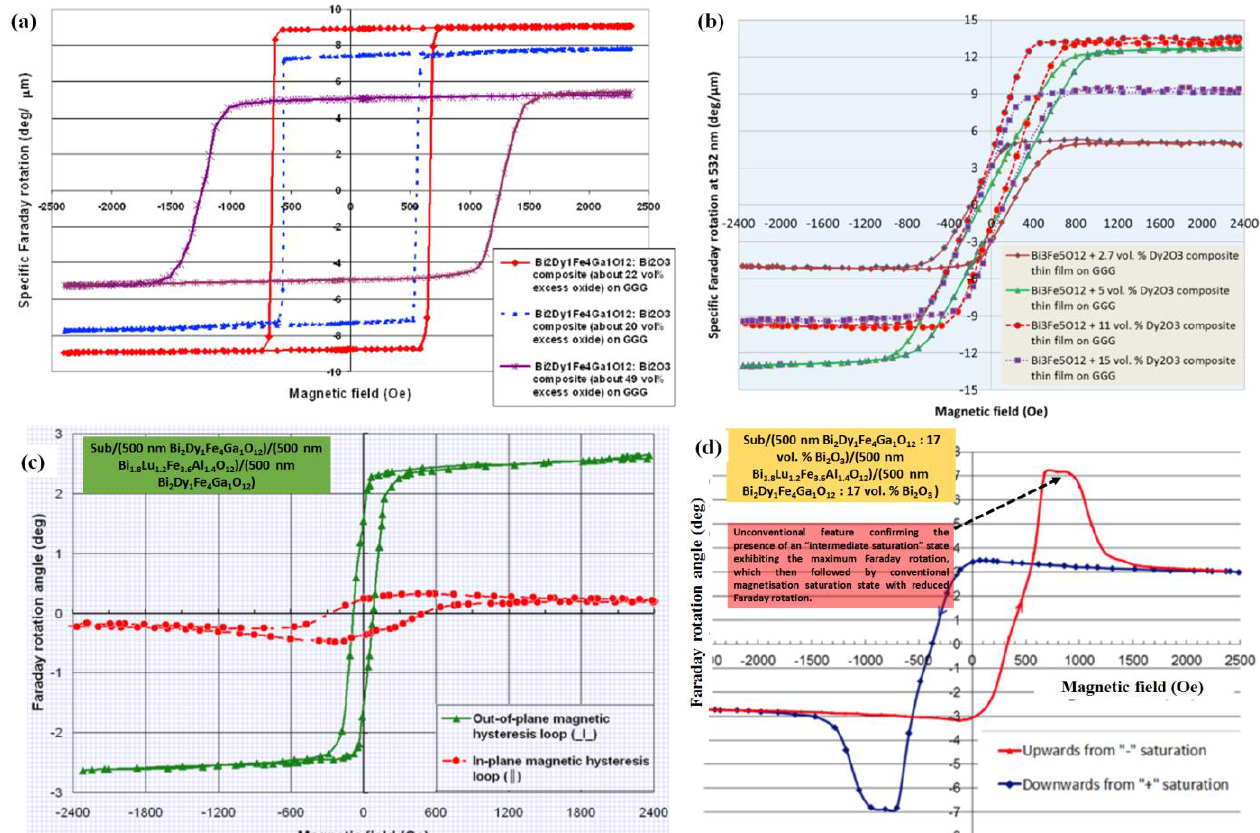
Figure 8. Measured hysteresis loop of Faraday rotation in different types of garnet-oxides composite layers and multilayer structures. The effects of excess oxide content added to the base garnet layers were observed. Measured hysteresis loops of ((Bi,Dy) 3 (Fe,Ga) 5 O 12 : Bi 2 O 3 ) composite films having different volumetric fractions of extra Bi 2 O 3 ( a ), Bi 3 Fe 5 O 12 : Dy 2 O 3 ) (2.7-15 Vol. %) composite thin films